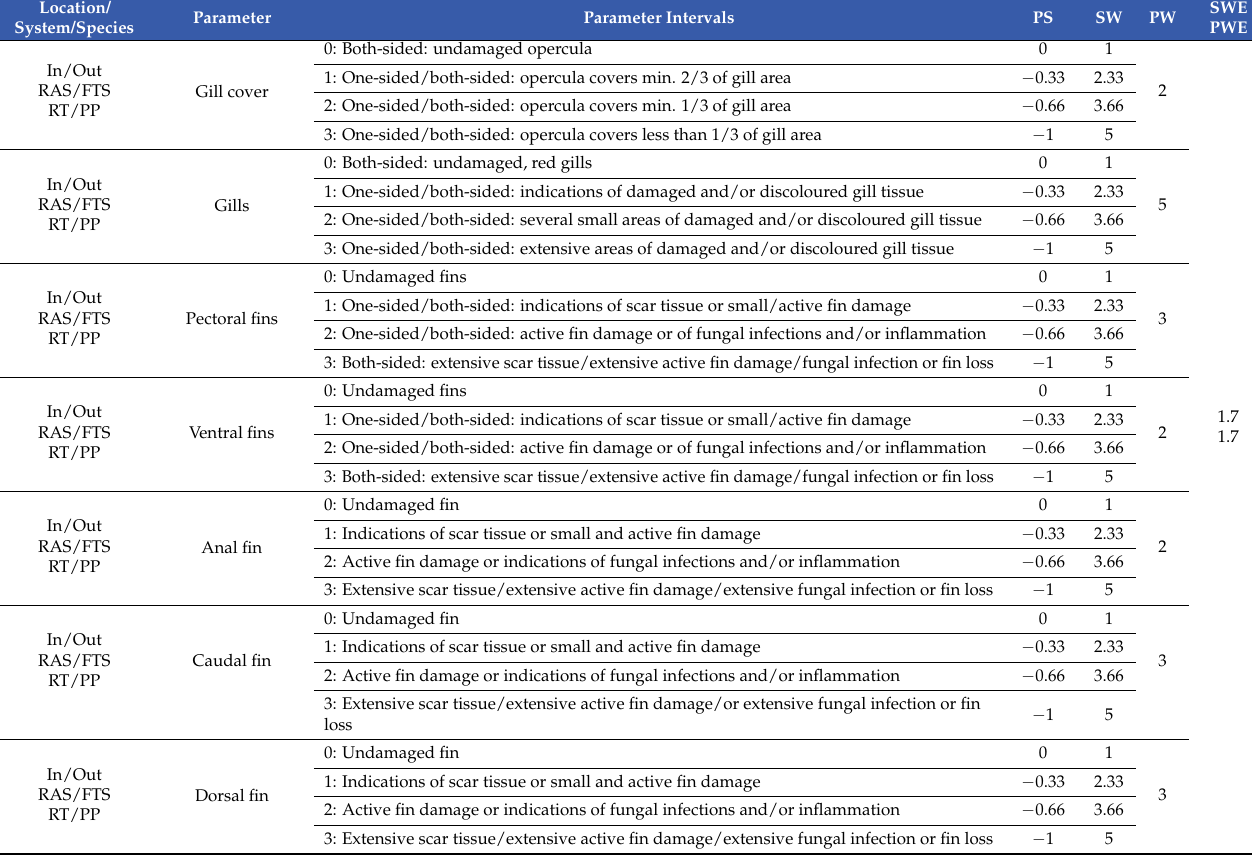
Table A6. Module fish external appearance (2/2). In = indoor, Out = outdoor, RAS = recirculating aquaculture system, FTS = flow-through system, RT = rainbow trout, PP = pikeperch, PS = parameter score, SW = score weight, PW = parameter weight, SWE = score weight exponent, PWE = parameter weight